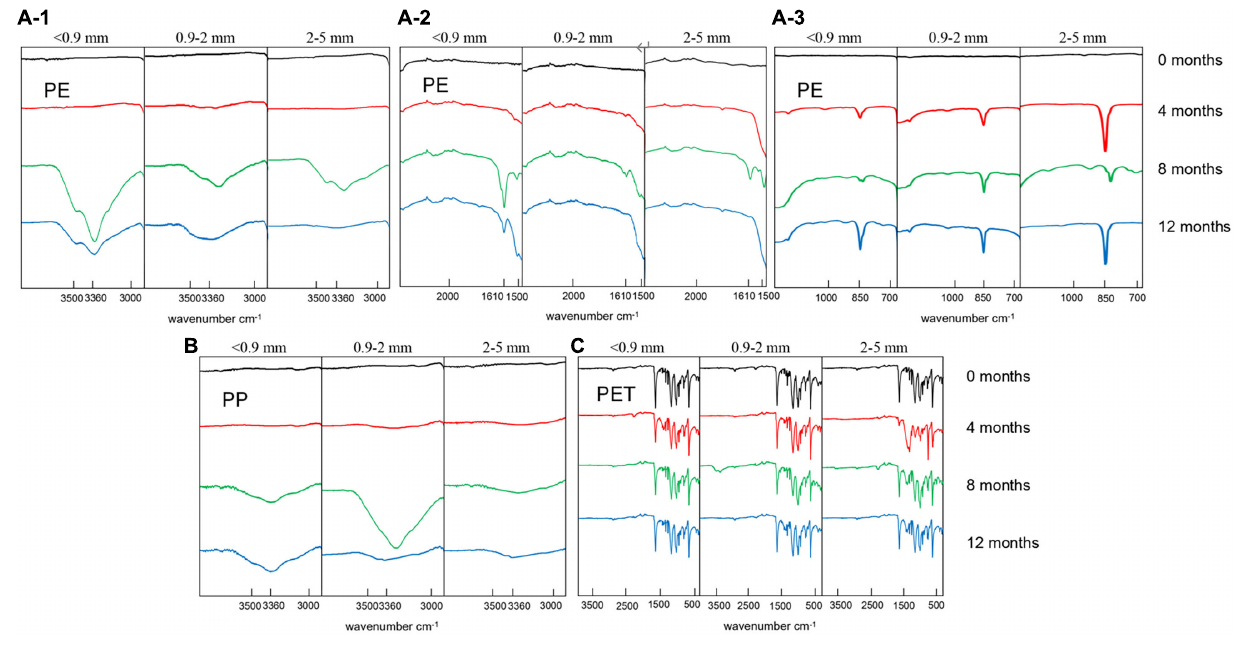
Frontiers in Marine Science |